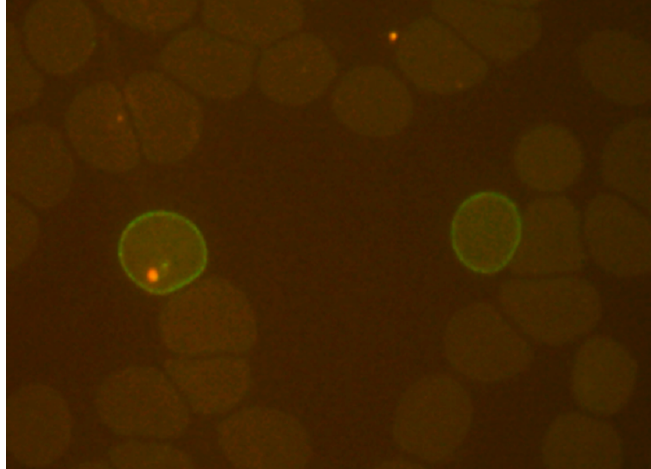
Figure 1. Immunofluorescence of peripheral blood film of P. falciparum -infected patients’ blood with post-artesunate delayed hemolysis. P. falciparum -infected red cells show positive staining with a monoclonal antibody to ring-infected erythrocyte surface antigen. The parasite was stained by acridine orange ( left ), and pitted red cells can be seen ( right ) ( × 1000 magnification). The mechanism of pitting aids in the removal of dead parasites without causing hemol- ysis [17,25,29]. The debris of dead organisms is later engulfed by splenic macrophages, whereas the intact “once-infected” red blood cells travel back to the host’s circulation. However, pitting causes the once-infected red blood cells to become smaller with impaired structural integrity [27]. As a result, the life span of these once-infected red blood cells becomes considerably shortened, to approximately 7–21 days [28]. This mechanism is more frequently found with a higher pitting rate in artesunate-treated patients than in those who are treated with quinine [28,29]. Therefore, PADH is more likely to occur in artesunate-treated patients with a higher parasitemia level because there is a larger number of short-lived pitted red blood cells [26]. A cohort study conducted in western Africa con- firmed this likelihood by showing that those with higher geometric mean parasite densities (GMPD) resulted in a higher incidence of hemolytic anemia on day 14 than those with lower GMPD (306,968/ µ L vs. 92,642/ µ L) [14]. However, PADH has also been reported in individuals with a low parasite count. The pitting mechanism is shown in Figure 2. PADH is not only caused by the destruction of once-infected pitted cells but also by the destruction of uninfected red blood cells. In some cases, hemoglobin concentrations unexpectedly rapidly decrease. There may also be artesunate-suppressed hematopoietic precursor cells in bone marrow, causing the impairment of terminal erythroid differentiation via a direct effect on erythroblasts and indirectly via macrophages, as well as reticulocyte maturation. Several in vitro and in vivo studies in both human cells and animals suggested that artemisinin and derivatives have the dose-dependent inhibition of the proliferation of proerythroblasts and basophilic erythroblasts and erythroid differentiation effects. These effects consequently decrease erythrocyte and reticulocyte counts, a sensitive measure of erythropoiesis inhibition. Reticulocyte depletion is reversible and can return to a normal or higher level after the therapy. Therefore, the inhibition of erythropoiesis may contribute to PADH in patients receiving a high dose of artesunate